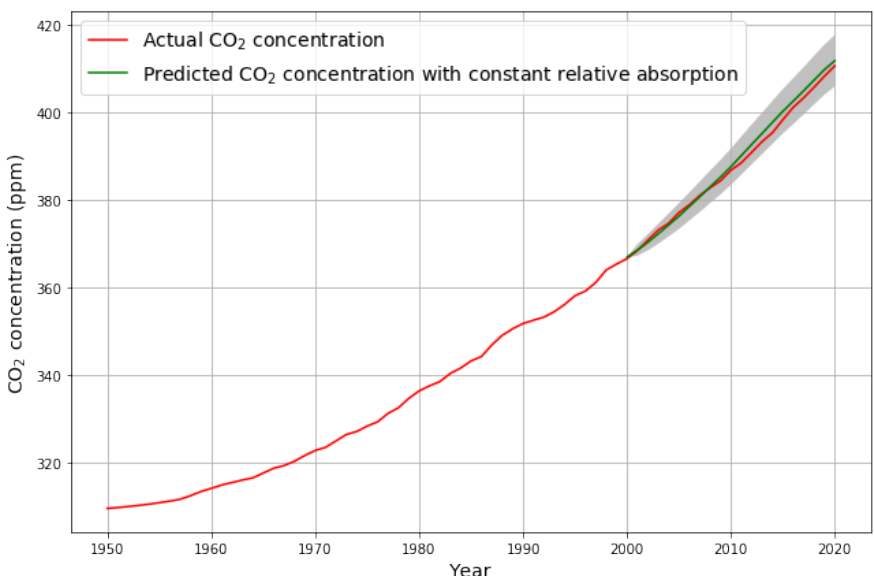
Figure 6. Actual (1950–2020) and predicted (2000–2020) CO 2 concentration.